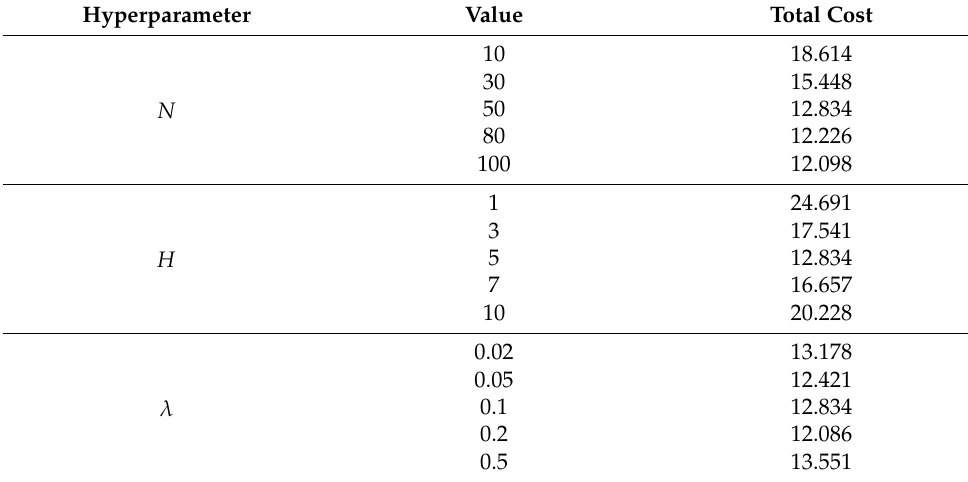
Table 2. The impact of hyperparameters on